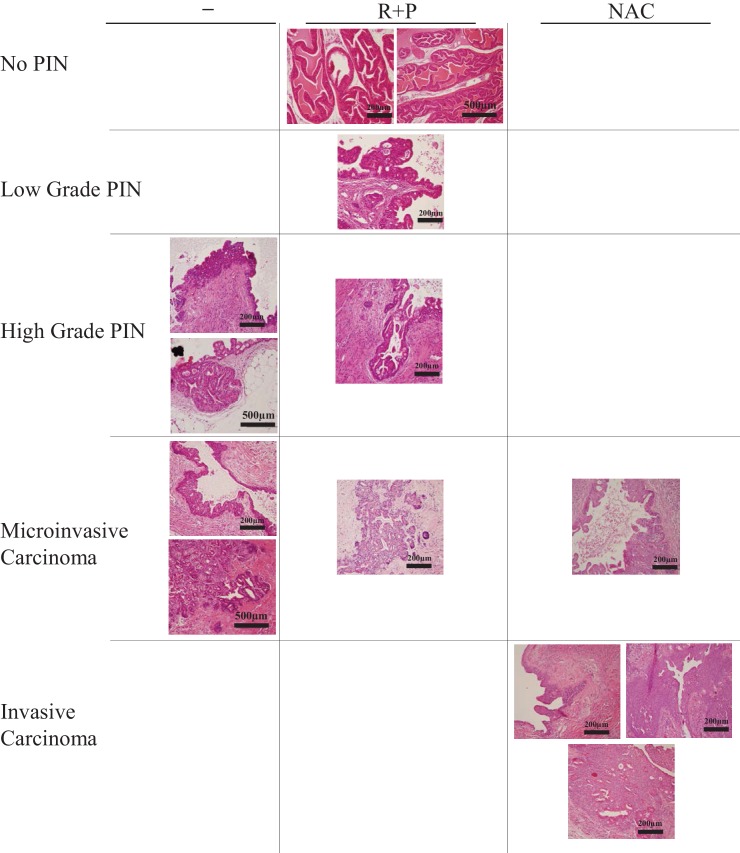
Representative histopathological images.Representative images of different prostate tumor grades in the anterior lobe of the prostate of untreated mice (-), rapamycin +PEITC-, and NAC-treated mice. The individual images were derived from different individual mice. Scale bars = 200 µm for 20× magnification, 500 µm for 10× magnification.